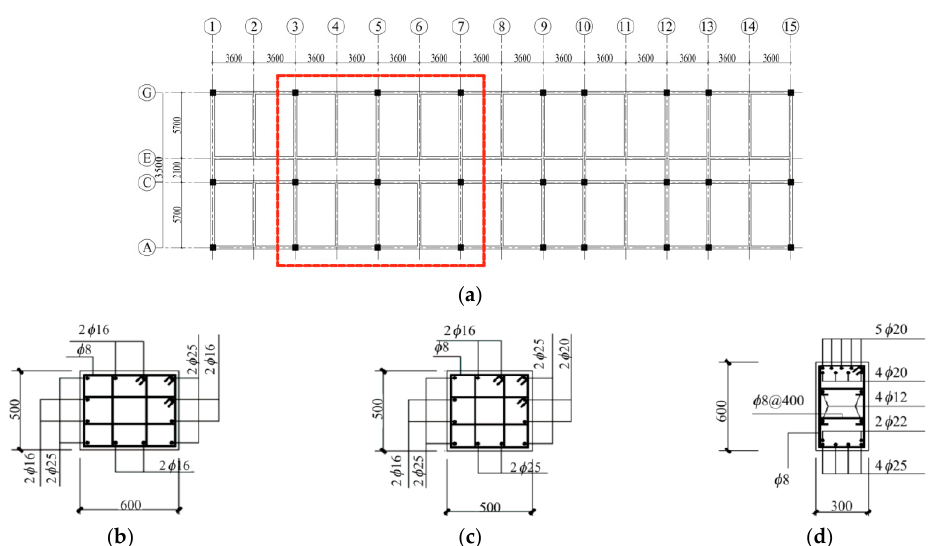
Figure1. Plan and details of the prototype (Unit: mm). ( a ) Plan; ( b ) Side column section; ( c ) Centre column section; ( d ) Beam section.